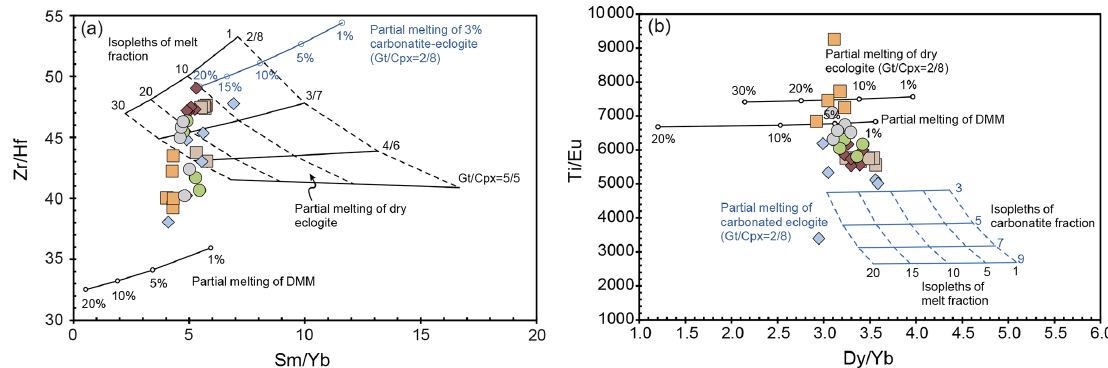
Figure 12. (a) Zr / Hf vs. Sm / Yb and (b) Ti / Eu vs. Dy / Yb in Wulanhada basalts, compared with calculated values using the non-modal batch melting model after Shaw (1970). For the details of calculation see Zou et al. (2022). Numbers against isopleths show the degrees of partial melting (black) and the amount of carbonatite in the source (blue). Data sources: carbonates (Hoernle et al., 2002), depleted MORB mantle (DMM; Workman and Hart, 2005) and MORBs (Gale et al.,